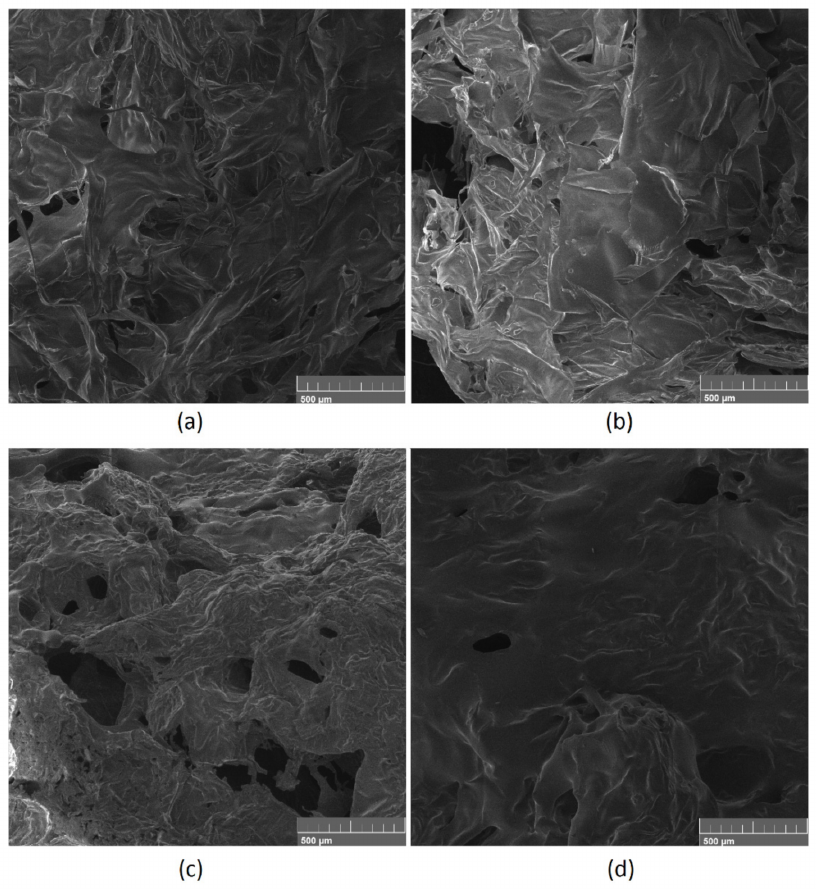
Figure 15. SEM microphotographs showing surface roughness of ( a ) Gel-1, ( b ) Gel-2, and ( c ) Gel-1 after incubation with blood; ( d ) Gel-2 after incubation with